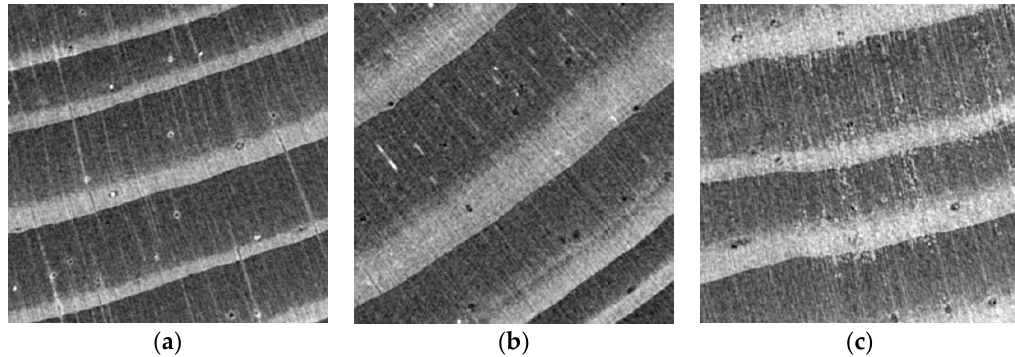
Figure 13. Exemplary cross sections of samples: ( a ) “1” ; ( b ) “2” ; ( c ) “3” (scale 200%).